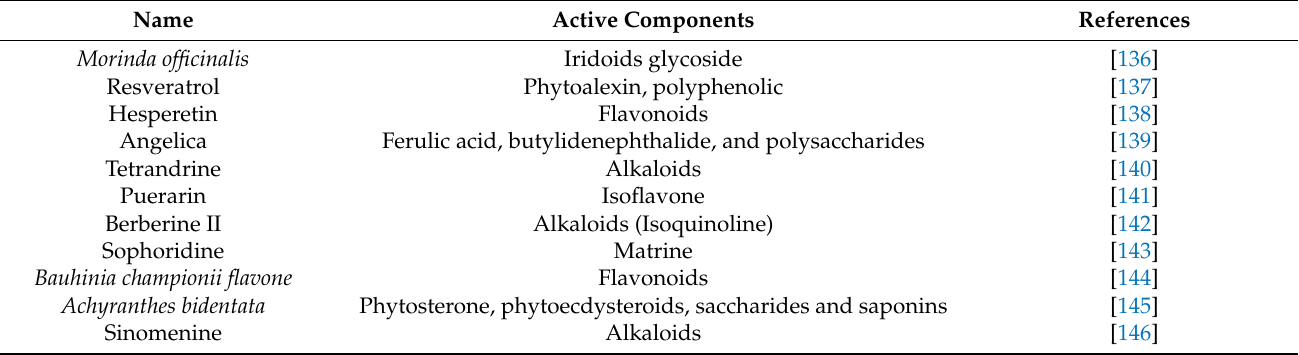
Table 2. Alternative treatment options for controlling apoptotic events in tibial